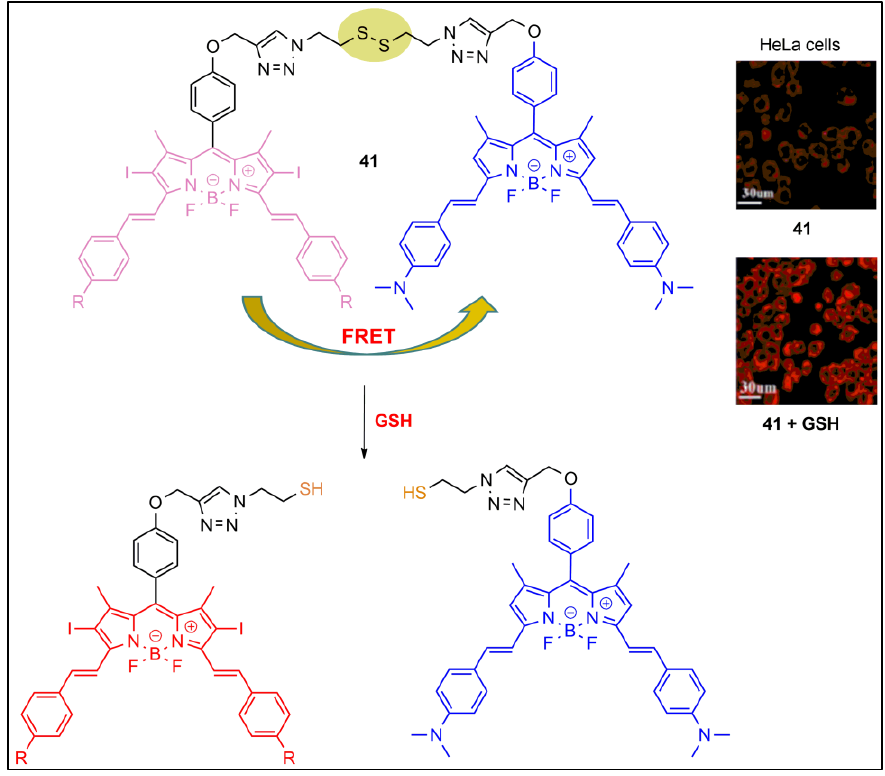
Figure 42. Schematic illustration of the proposed activation mechanism of probe 41 . Confocal images of HeLa cells after incubation with 41 (10 µ M) for 8 h (upper image) and cells pre-treated with GSH (5 µ M) for 2 h, followed by treatment of 41 (10 µ M) for another 8 h (lower image). Adapted with permission from [126]. Copyright (2020)